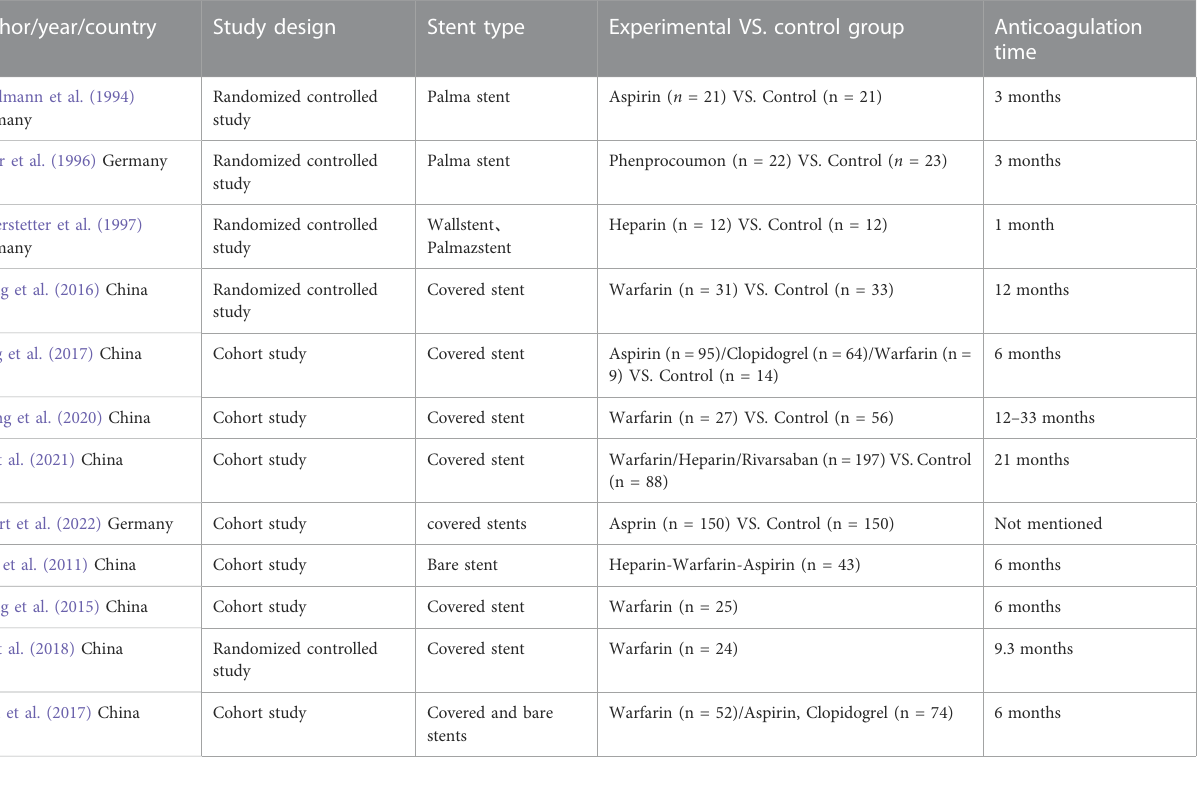
TABLE 2 Basic characteristics of included studies.